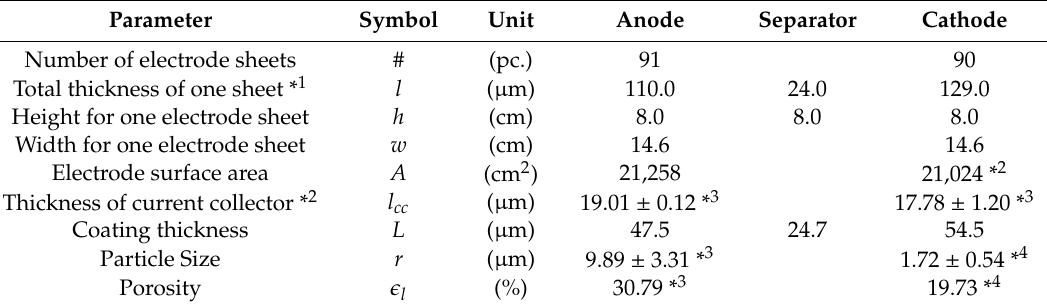
Table 3. Geometrical data of the 40 Ah battery